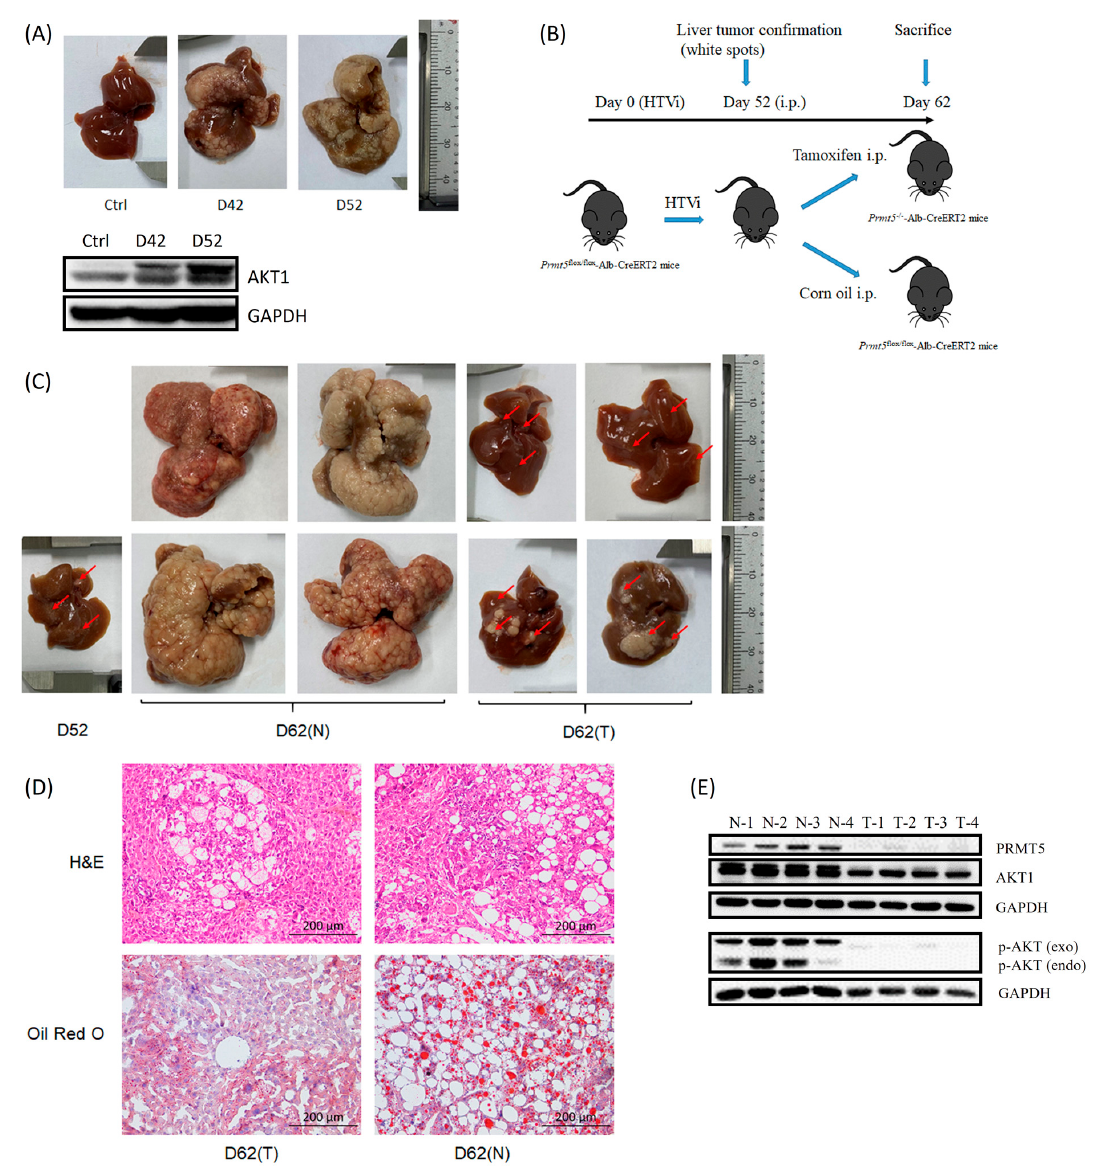
Figure 6. Liver-specific Prmt5 deficiency inhibits primary HCC progression. ( A ) Upper panel: livers dissected from the C57BL/6J mice untreated or treated with HTVi at the 42nd, or 52nd day post- treatment. Lower panel: the expression level of AKT1 of liver tissue or tumor from the mice. Ctrl: untreated controls; D42: HTVi treated mice at the 42nd day post-treatment; D52: HTVi treated mice at the 52nd day post-treatment. ( B ) The primary HCC model induced by overexpression of AKT1 and N-RasV12 using HTVi and liver-specific Prmt5 KO treatment (i.p.: intraperitoneal injection). ( C ) Livers dissected from the HTVi treated Prmt5 flox/flox -Alb-CreERT2 mice with or without Prmt5 deficiency at the 52nd, or 62nd day post-HTVi treatment (white spots with red arrows represent spontaneous lesions). ( D ) The morphological change in liver tissue or tumor at the 62nd day post- HTVi treatment (200×). D: days after HTVi treatment; T: Prmt5 CKO group received tamoxifen in- traperitoneal injection; N: non-CKO received corn oil intraperitoneal injection. ( E ) The expression level of PRMT5 and AKT1, and the phosphorylation of AKT at Ser473 both exogenously (exo) and endogenously (endo) of liver tissue or tumor from mice. N-1/4: non-CKO without tamoxifen injec- tion; T-1/4: CKO group received tamoxifen injection.